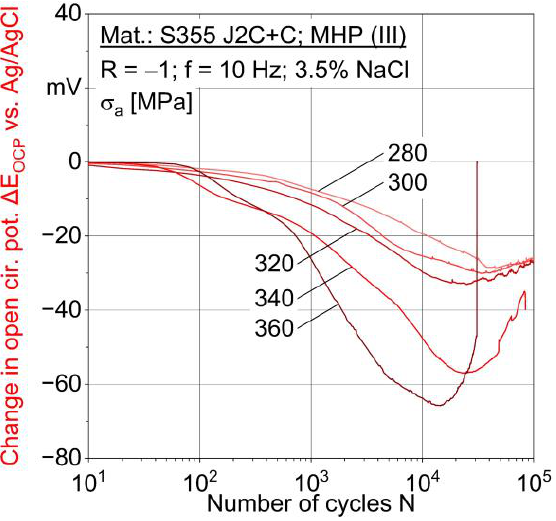
Figure 10. Change in open circuit potential within corrosion fatigue tests of machine hammer- peened (III) specimens in 3.5% NaCl